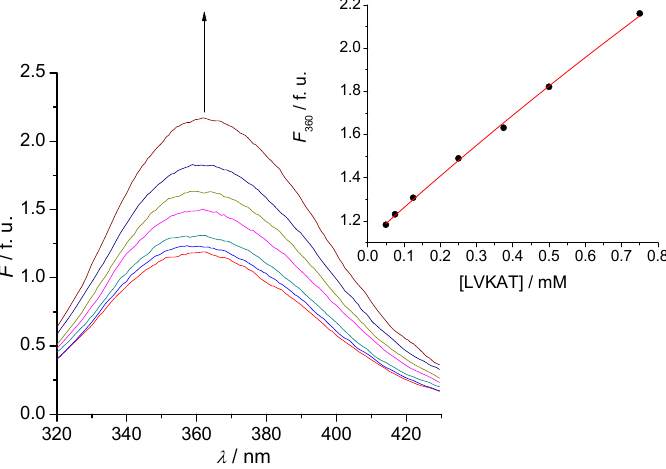
Figure 2. A typical titration of 2.5 μ M solution of α -MSH (sense) with LVKAT (antisense) at 25 °C, pH = 7.4, 10 mM phosphate buffer. The concentration of LVKAT was varied from 50 to 750 μ M. Fluorescence units (f.u.) are given as a ratio of signals obtained from sample and reference PMTs. Inset: Fitting curve at 360 nm according to the Equation (1) and Equation (2).